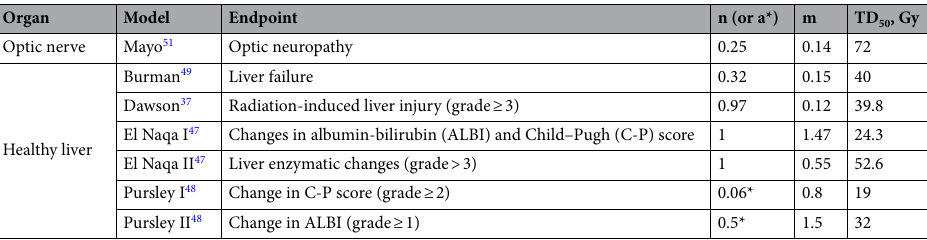
Table 2. Summary of the LKB NTCP model parameters used in the study. TD 50 is the value of the uniform dose given to the entire organ surface corresponding to the 50% probability to induce toxicity; m is inversely proportional to the slope of the dose–response curve; and n (or a) accounts for the volume